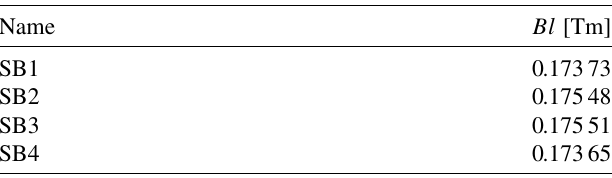
TABLE III. Central orbit trajectory with the shift-bump sys- tem before and after the Bl normalization at the foil position ( s (cid:4) 82 : 113 m ) and at the exit of the shift-bump field area ( s (cid:4)